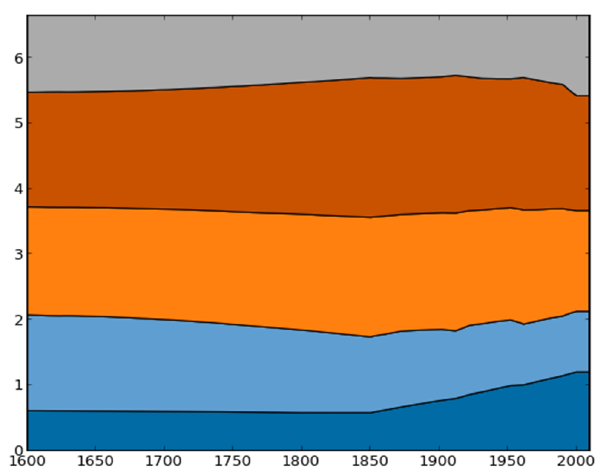
Figure 3. Land surface area in 10 6 km 2 covered by forest (blue), grassland (orange), cropland (brown) and bare soil (grey) between 1600 and 2010. The forest area is further separated into coniferous (dark blue) and deciduous (light blue)